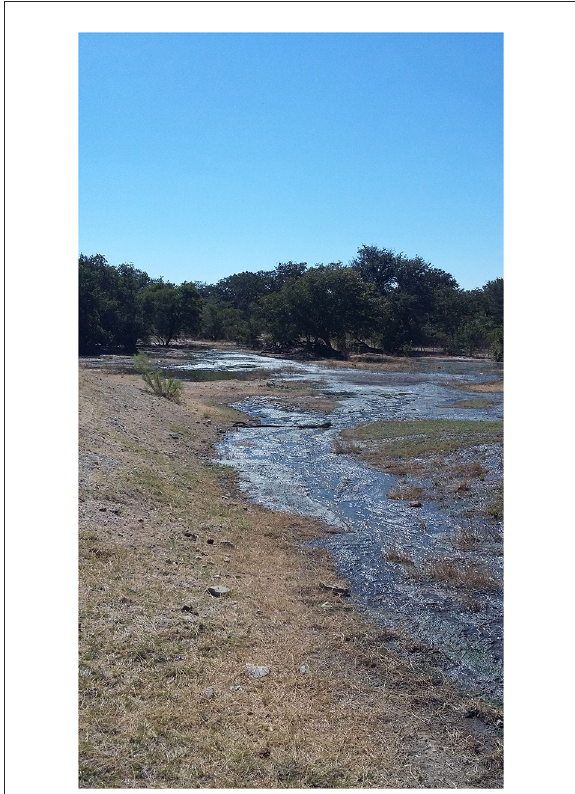
FIGURE2 Overflowing of untreated wastewater from a Waste Stabilization Pond (WSP) in Eenhana municipality in 2018. Photo: Fanny